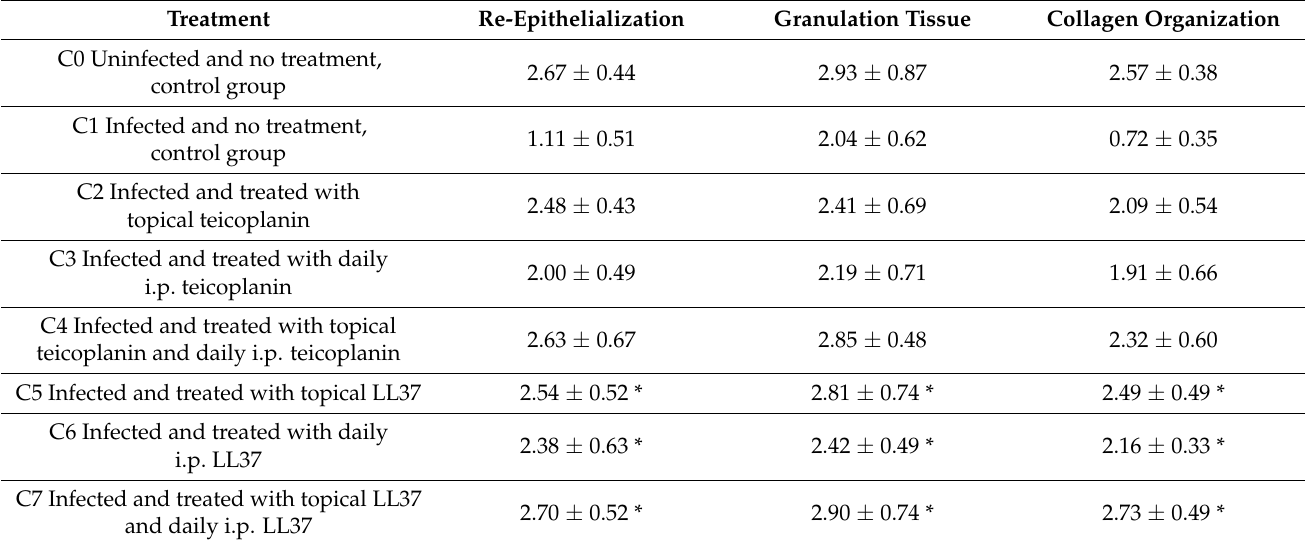
Table 1. Summary of the biological impact of different treatment modalities on wound healing parameters at day 7 post-wounding. Data are expressed as the mean score ± SD.